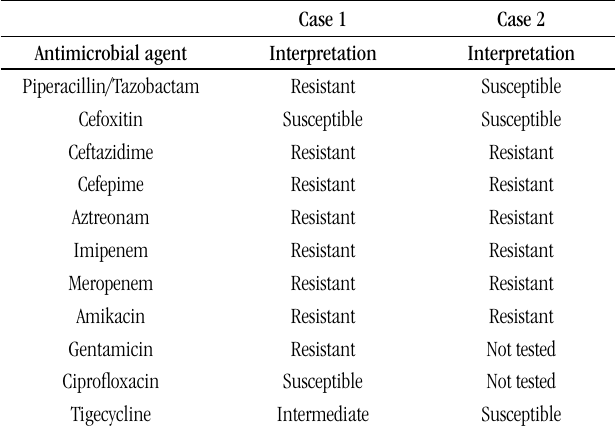
tABLE − Antimicrobial susceptibility profile of E. meningoseptica isolated from two cases Case 1 Case 2 Antimicrobial agent